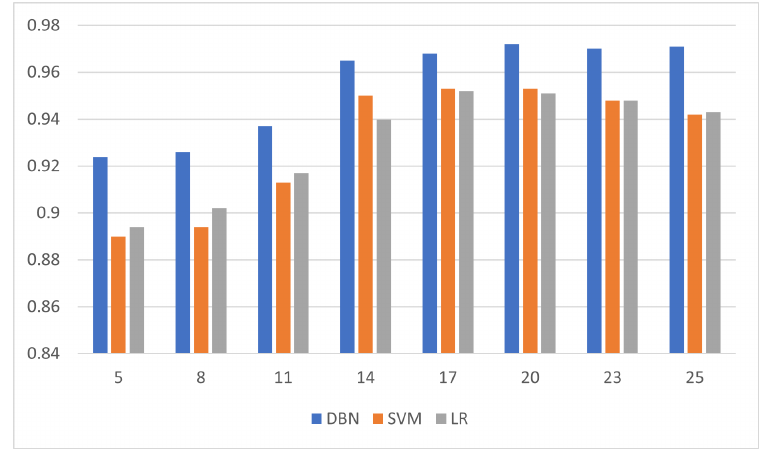
Figure 2. Comparison of the proposed ADBN-IDS with SVM and LR in terms of detection rate.